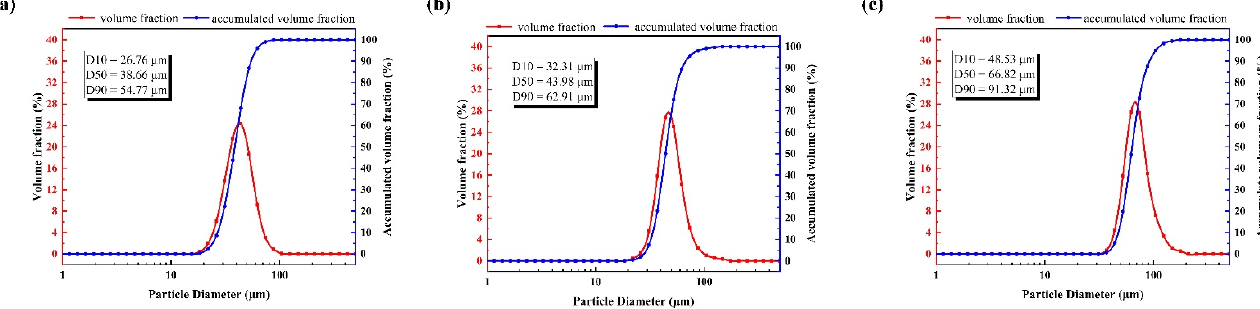
Figure 2. Particle size distribution of ( a ) gadolinium zirconate powders, ( b ) mixed powder of gadolinium zirconate and YSZ, and ( c ) rare-earth-doped gadolinium zirconate powders.